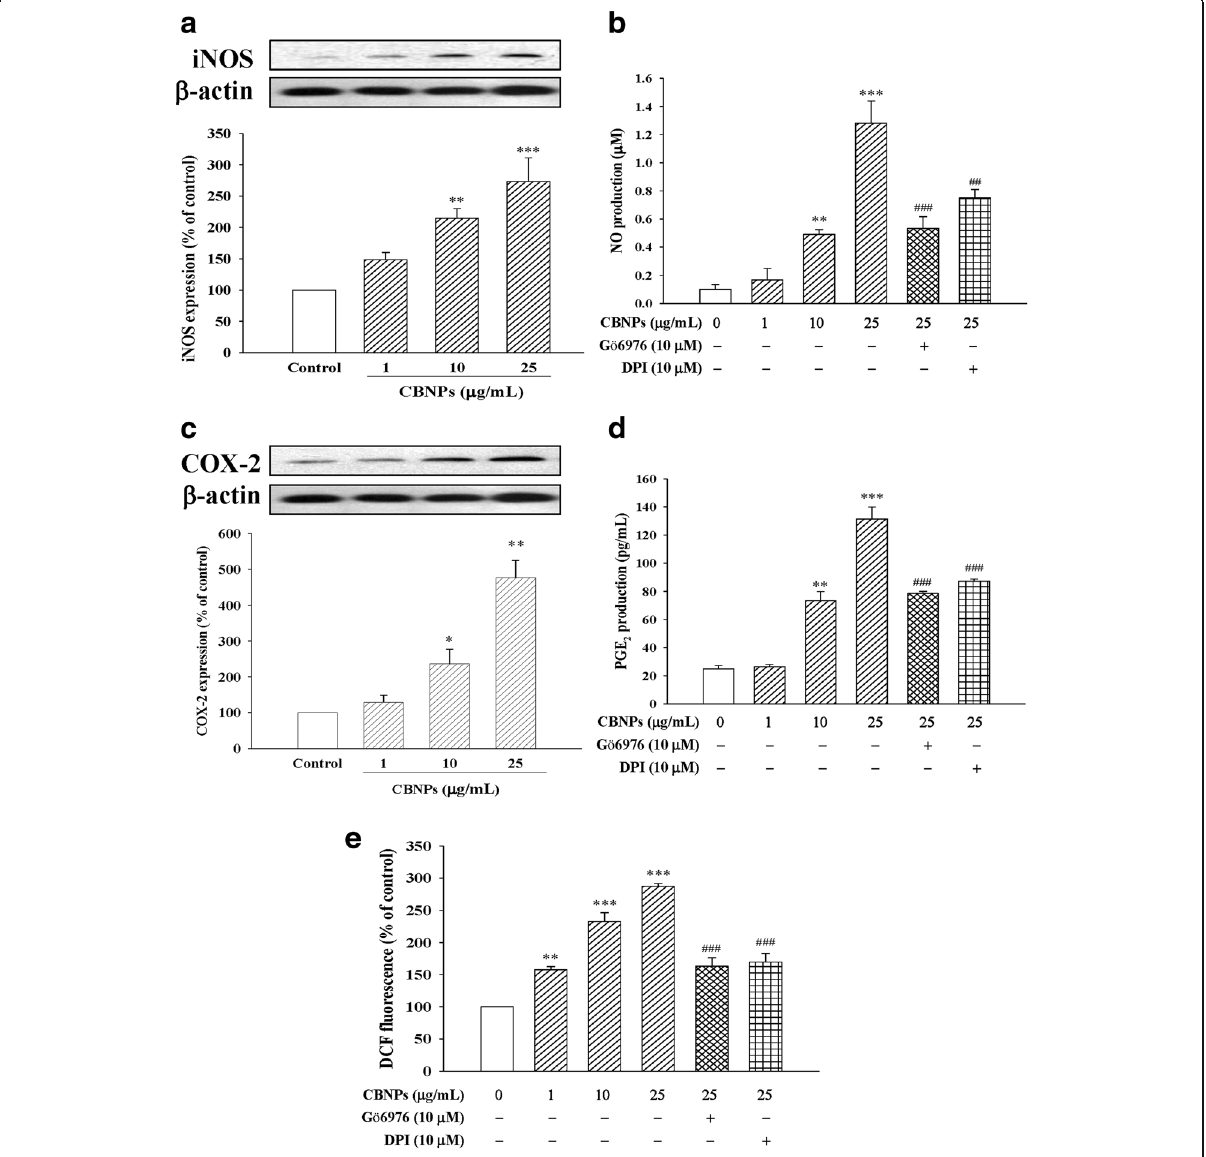
Fig. 3 Effects of CBNPs on iNOS expression ( a ), effects of Gö6976 or DPI on NO production ( b ), COX-2 expression ( c ), and effects of Gö6976 or DPI on PGE 2 production ( d ), and effects of Gö6976 or DPI on ROS production ( e ) in A549 cells. Cells were treated with CBNPs (1, 10, 25 μ g/mL) for 24 h or pretreated with Gö6976 or DPI for 1 h respectively, and then treated with CBNPs (1 – 25 μ g/mL) for 24 h. ROS production was measured using H 2 DCF-DA staining and detected the DCF fluorescence by flow cytometer. Bars represent the mean ± S.E.M. from six independent experiments. * P < 0.05, ** P < 0.01, *** P < 0.001 vs. control group (without any treatment). ## P < 0.01, ### P < 0.001 vs. CBNPs